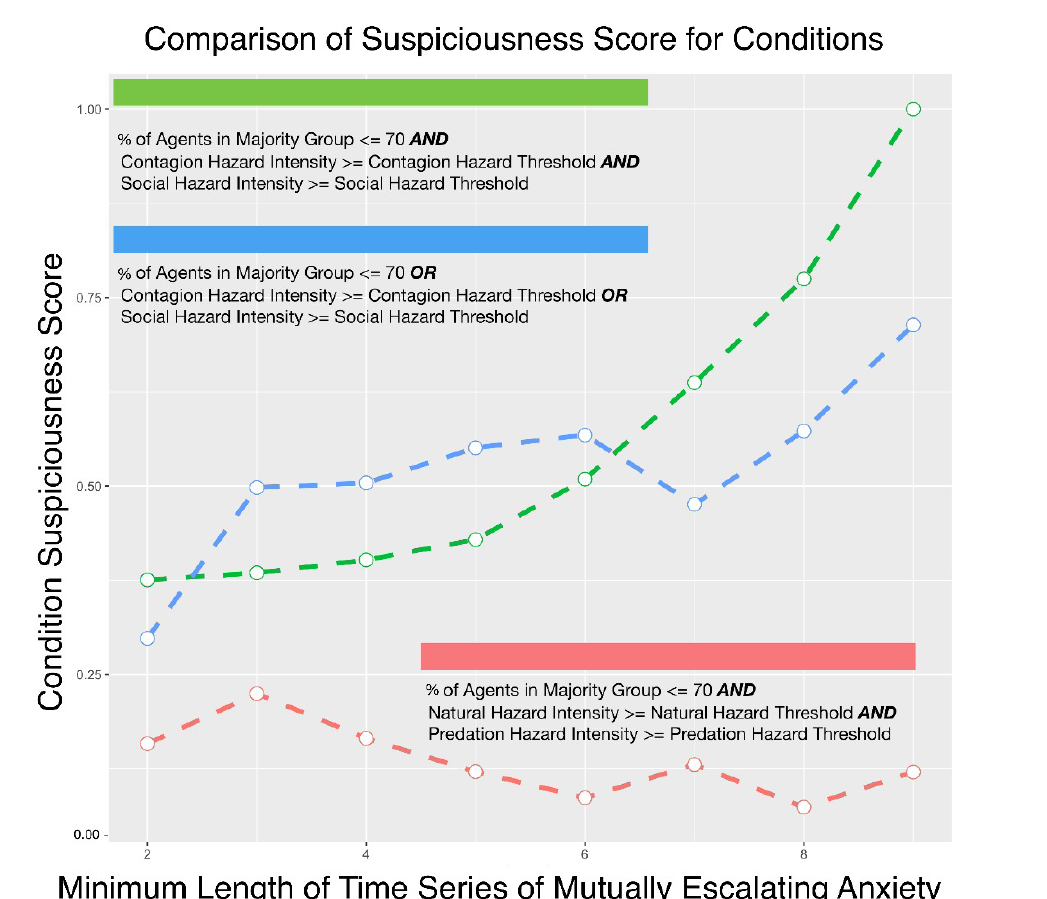
Figure 3: Conditions for mutual escalation of anxiety (a proxy for